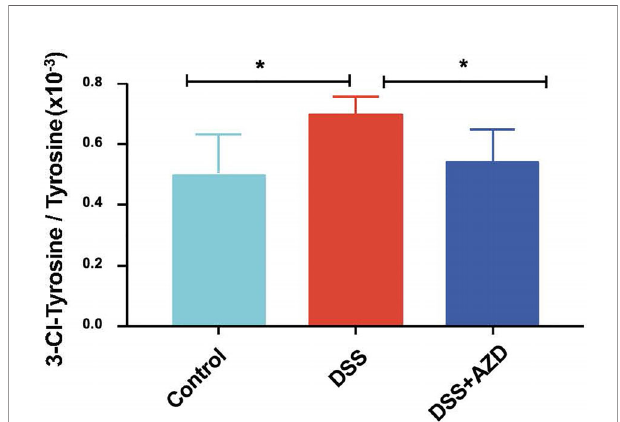
FIGURE 7 | Quanti fi cation of myeloperoxidase (MPO)-mediated oxidative damage biomarker 3-Chlor-Tyr with LC mass spectrometry in colon homogenates. Mice were randomly divided into three treatment arms over 9 days i) vehicle group (n = 5) given normal drinking water and peanut butter without drug; ii) dextran sodium sulfate (DSS) group (n=5) given 2% w/v DSS in drinking water and peanut butter without drug; iii) DSS+AZD3241 (n = 5)